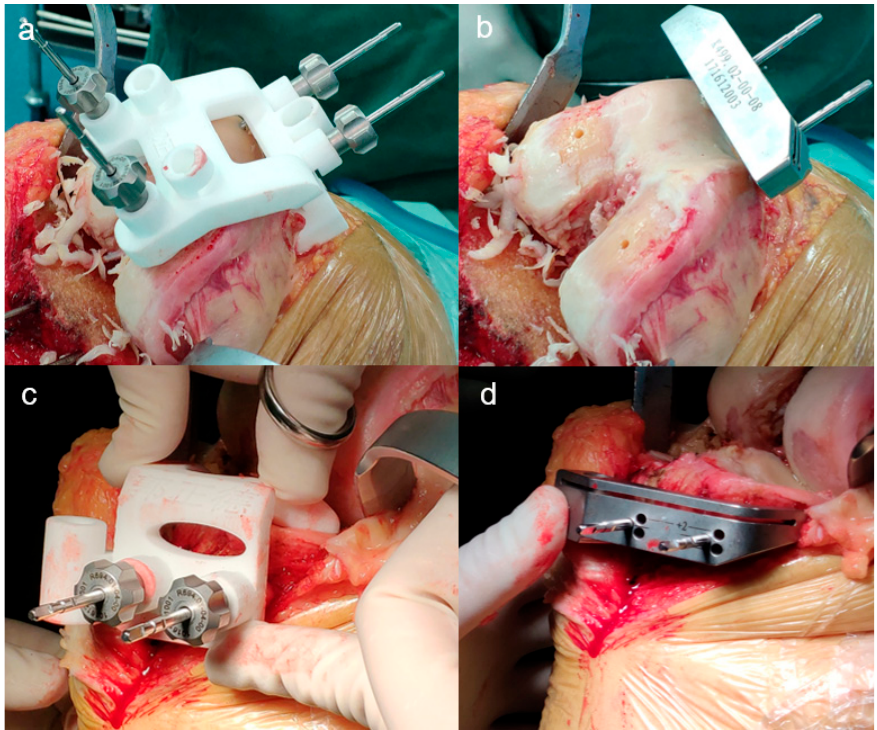
Figure 4. PSI was used for positioning of the key locating pins intraoperatively. ( a ) Two pairs of locating pins were drilled through the cannulas integrated into the femoral PSI. ( b ) The distal pins and PSI were removed, and a distal femur cutting block was seated in line with the remaining pins for distal bone resection. The two pin holes at the distal condyle were used for positioning of the 4-in-1 cutting block. ( c ) Locating pins were drilled through the cannulas integrated into the tibial PSI. ( d ) Switching tibial cutting block for tibial bone resection.